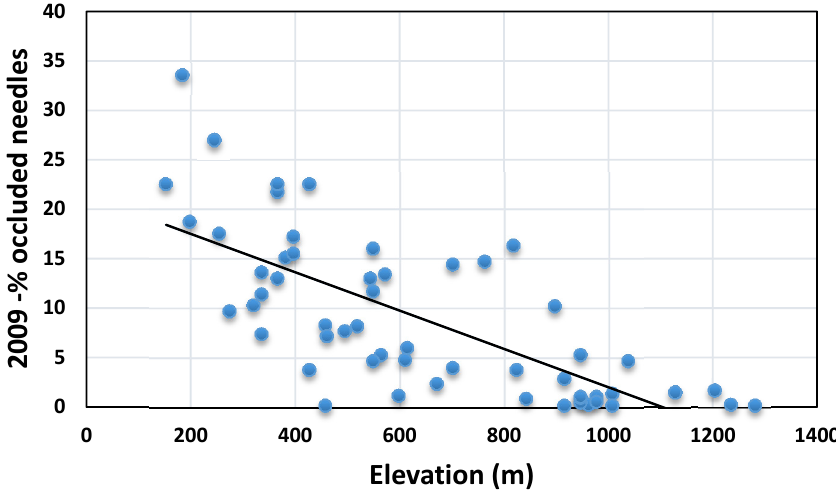
Figure 6. 2009 (2-year-old) needle-pseudothecial density vs. elevation. R 2 = 0.54, p < Figure 6. 2009 (2 ‐ year ‐ old) needle ‐ pseudothecial density vs. elevation. R 2 = 0.54, p < 0.0001.